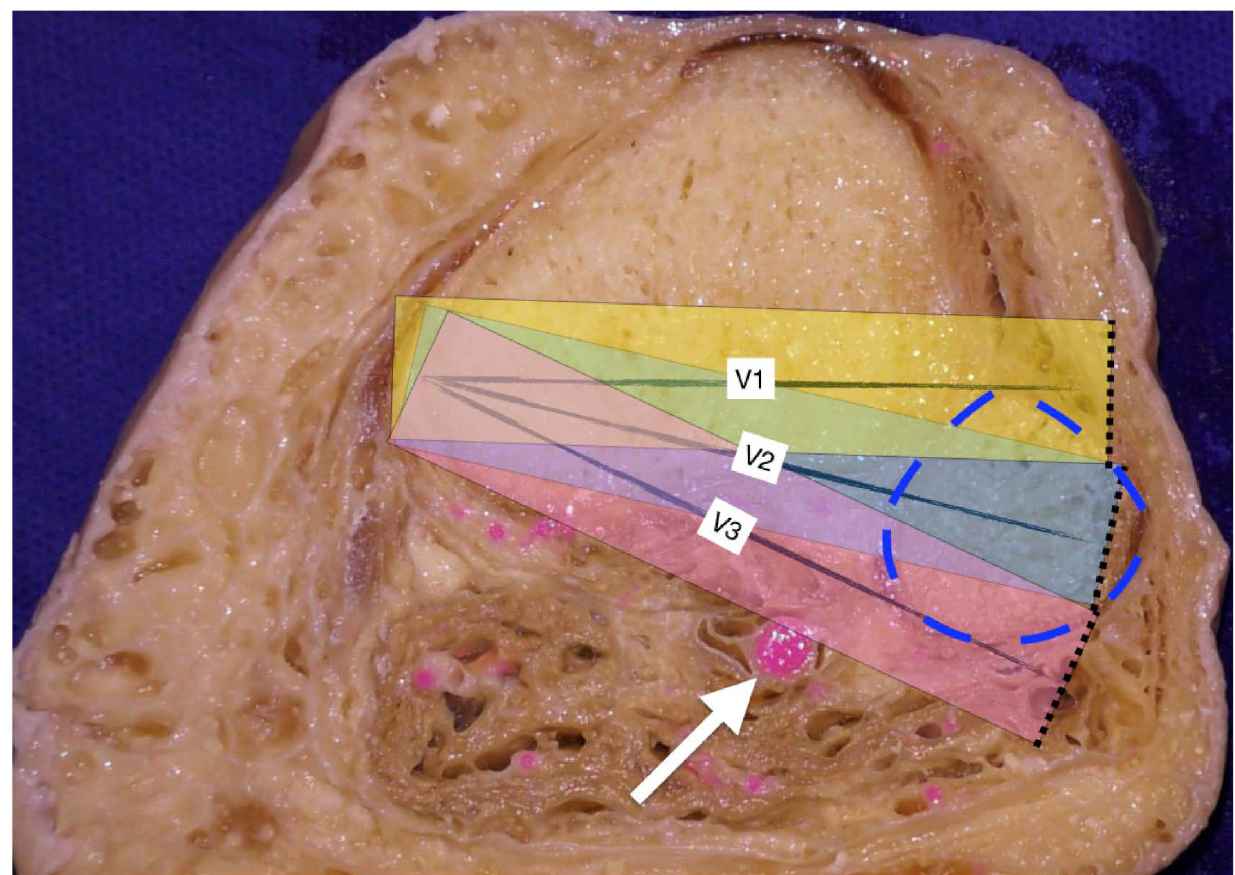
Figure 6. Axial cut of the right tibia approximately at 3 cm below the joint line. Kang et al. measured safe angles and distances in a virtual environment during HTO by taking into consideration that the functioning saw oscillates within a width of 35 mm [6]. They also assumed that the surgeon will perform the osteotomy in three possible virtual directions (V1 = 10 0 anterior to the anterior edge of the fibula head, V2 = the mid-portion of the fibula head and V3 = 10 0 posterior to the posterior edge of the fibula head). The width of each parallelogram represents the working width of the oscillating saw. It was assumed that the center of the saw blade runs along each virtual direction (V1-3). There was no risk of popliteal artery injury when sawing was performed along V1. When virtual sawing was performed along V2, Kang et al. found that the popliteal artery was at risk of injury in about 42% of cases. The risk of popliteal artery injury rose to 100% when sawing was performed along V3 [6]. White arrow: popliteal artery. Blue dotted line: head of